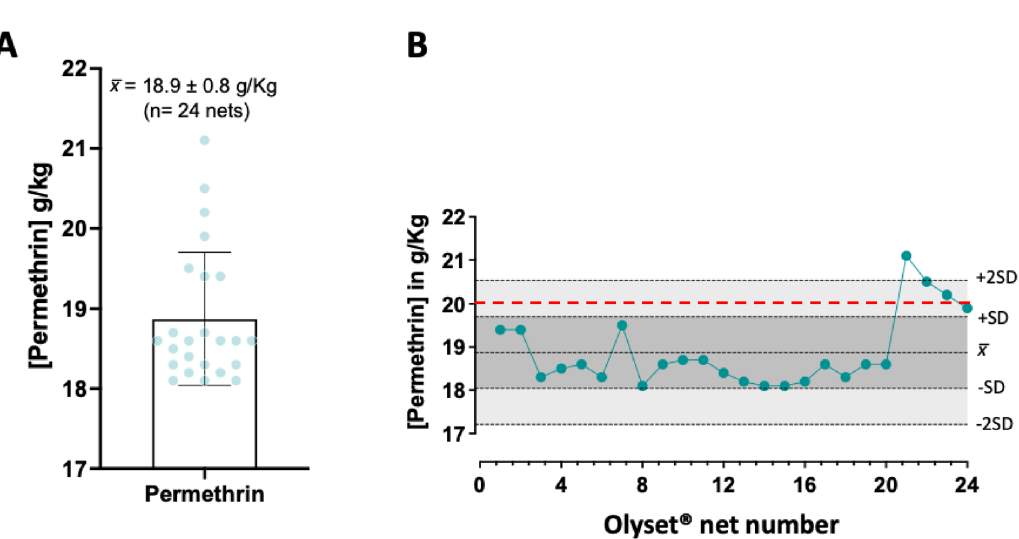
Figure 5. Analysis of total permethrin content in Olyset® net. ( A ) Permethrin ± standard deviation (SD) for 24 nets analyzed by the optimized method. ( B ) Levy-Jenning’s chart for pyriproxyfen content in 24 LLINs was analyzed in triplicate (72 samples in total) by the optimized method. An average (x ̄ ) of 18.9 ± 0.8 g permethrin/ kg (w/w) determined for Olyset® Net (n = 24) in reference to the target concentration of 20 g/kg as declared by the manufacturer and indicated as a dotted red line on the